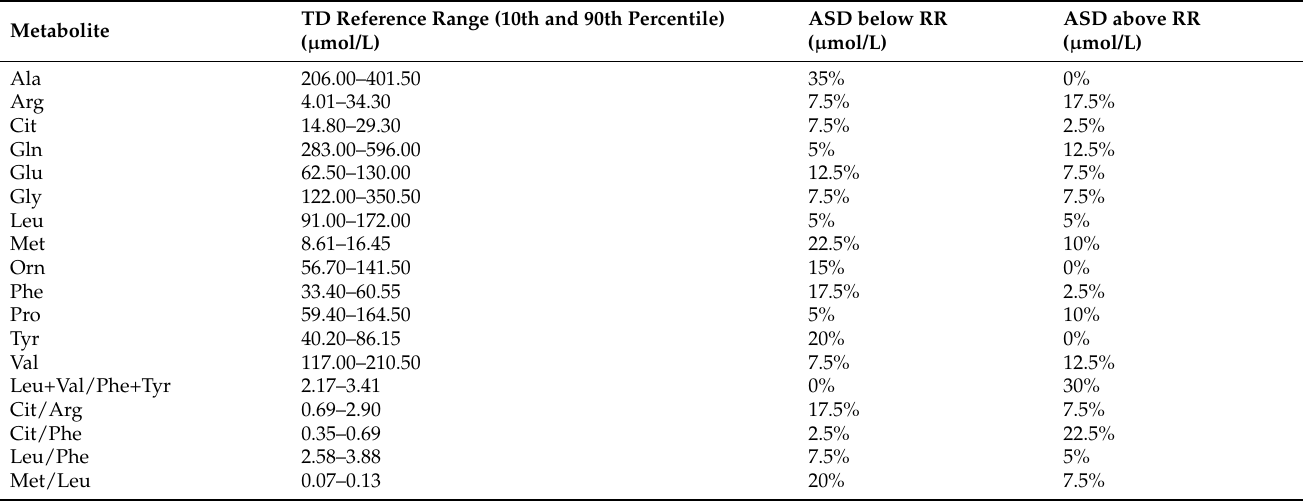
Table 3. ASD subjects (%) presenting with individual amino acid or ratio outside the reference range